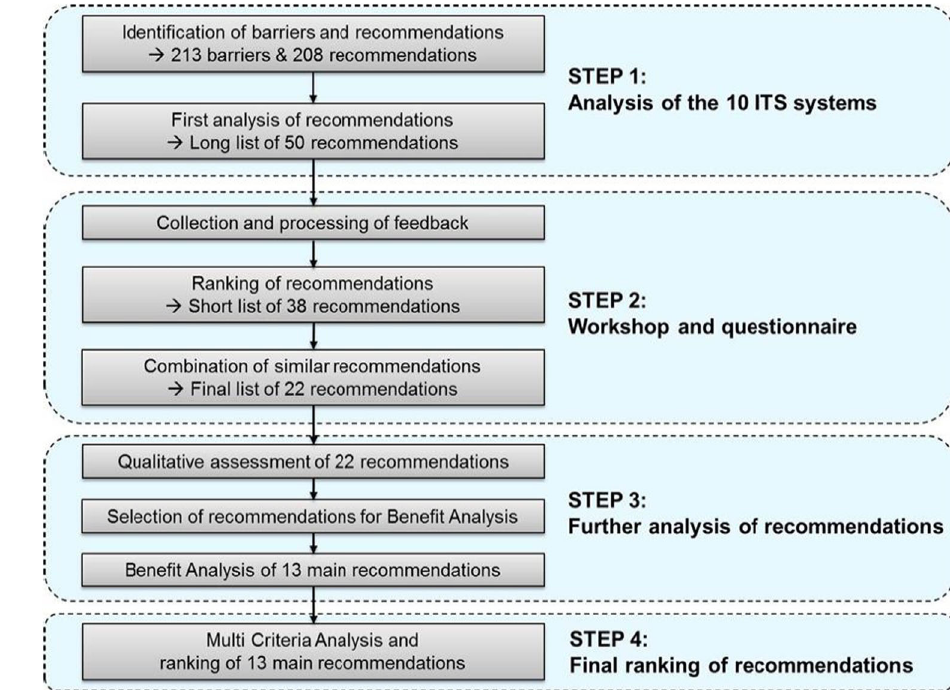
Fig. 1 Overview methodology ‘ General recommendations